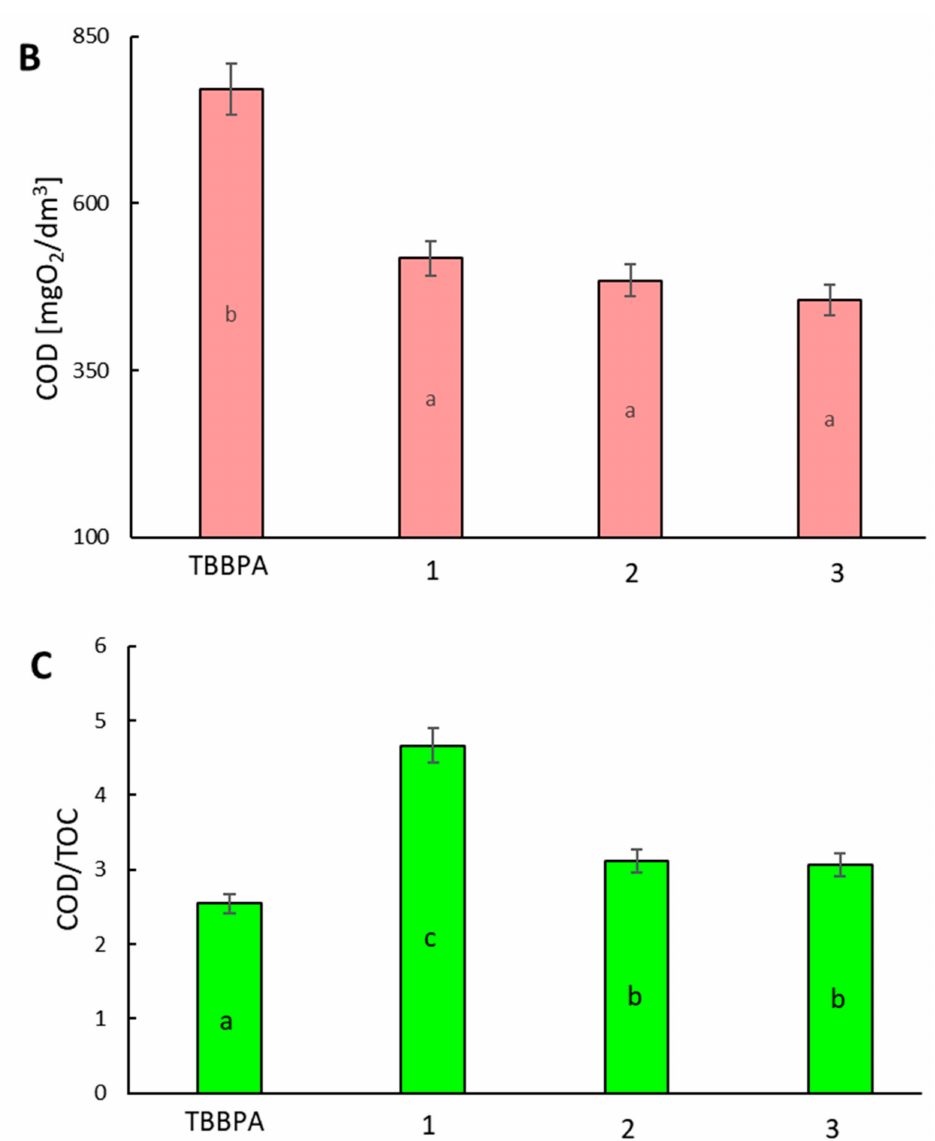
Figure 4. Concentration of organic compounds in solutions of raw TBBPA and products of AOP treatment expressed as a total organic carbon (TOC) ( A ), chemical oxygen demand (COD) ( B ), and TOC/COD ratio ( C ). The mean value ± SD, n = 3 of the result was presented, statistical ( p < 0.01) differences between the results, assessed by Statistica 13.1 Student’s test, are indicated by different